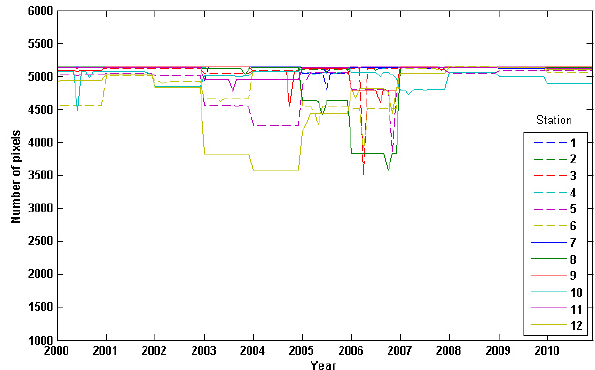
Figure A1. The number of average monthly pixels from each of the 12 radars used in the analysis.